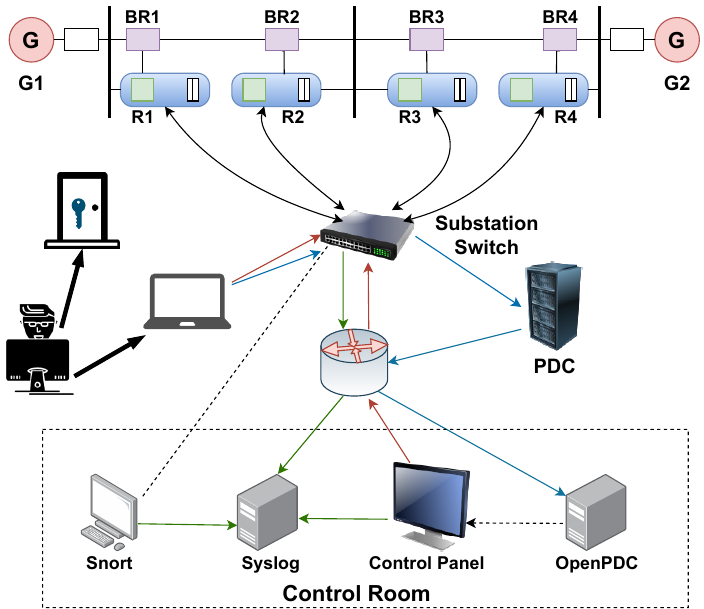
Figure 3. Power system framework